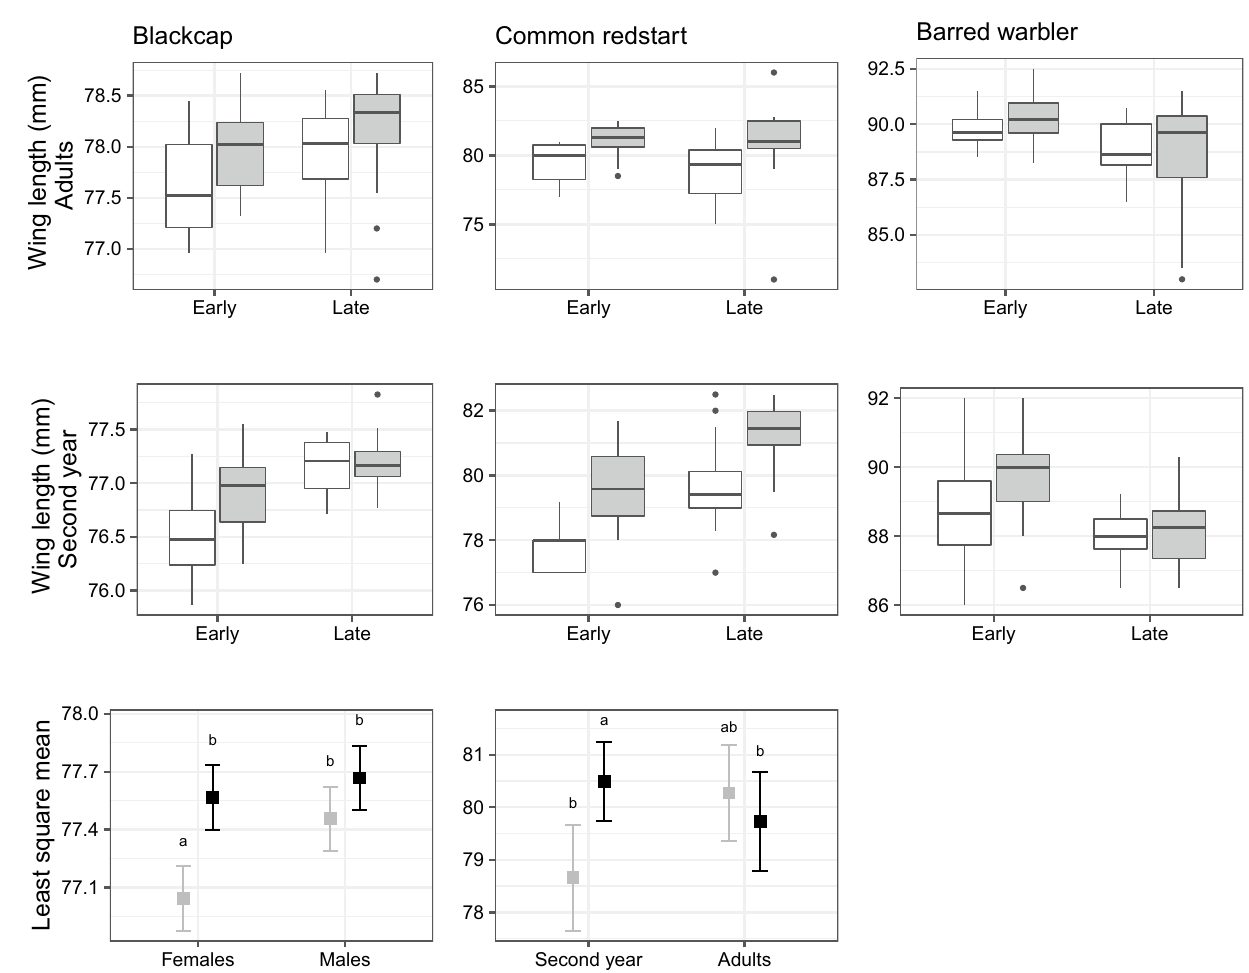
Figure 2. Wing length differences between arrival phases in the study species. Box-and-whisker describing the mean yearly wing length of adults (first row) and second year (second row) migratory passerines caught at a stopover site in Israel during spring migration. On the x-axis, early and late arrivals of males (grey) and females (white). Early and late arrivals were calculated as the first and last 30% of individuals on their first capture, separated for males and females. Black stripes depict the median. Statistical models are detailed in Table 1. In the third row, least square (LS) means of wing length are shown in the two arrival phases (grey- early, black-late) separately for sex (in the blackcap) and age (in the redstart). Error bars indicate the 95% confidence intervals of the LS means. Means sharing a letter are not significantly different (Tukey-adjusted comparisons). This post hoc test was done following a significant interaction between sex and group in the model for the blackcap and age and group in the model for the redstart (Table